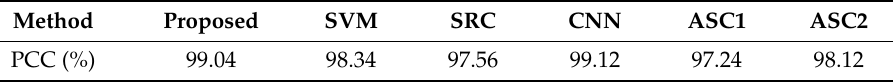
Table 4. Comparison of different methods under SOC.